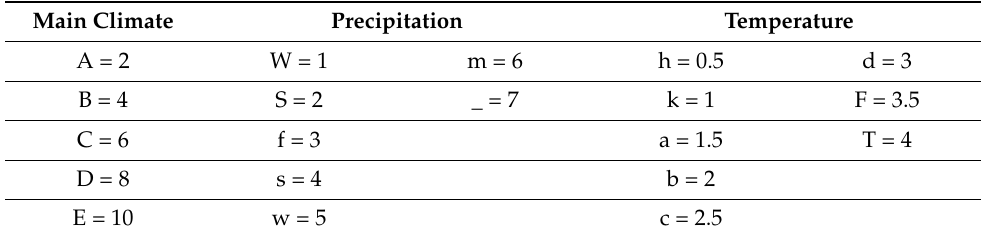
Table 1. Scores assigned for each climate